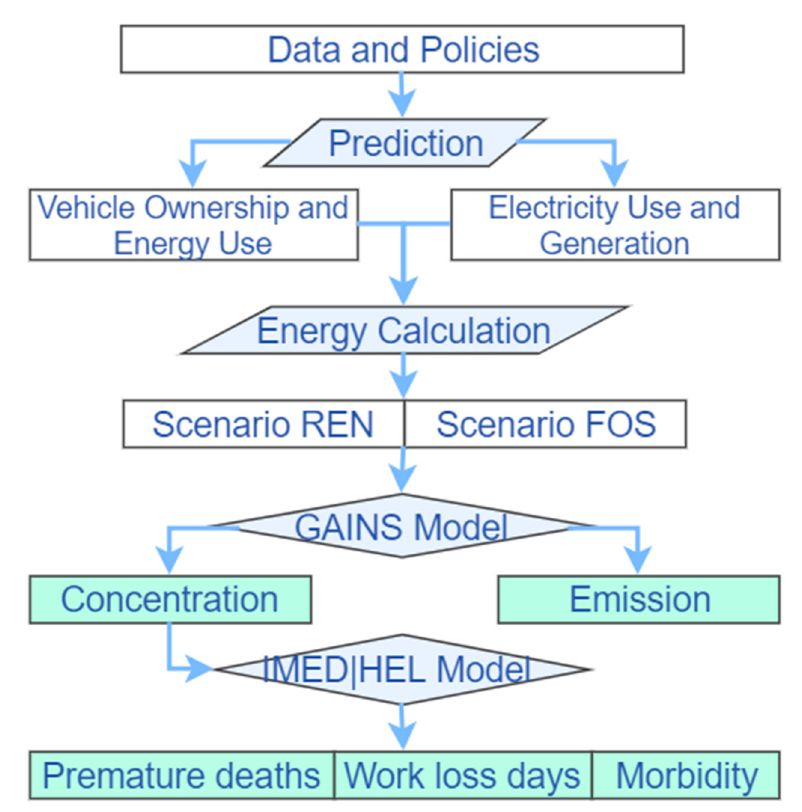
Figure 1. Research framework. REN: with electric vehicle policies scenario; FOS: without electric vehicle policies scenario. GAINS: Greenhouse Gas and Air Pollution Interactions and Synergy; IMED|HEL: Integrated Model of Energy, Environment and Economy for Sustainable Develop- ment/Health